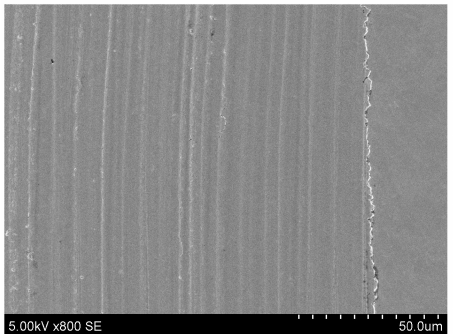
Figure 13. SEM images of a segment of wear trace on the plate formed during the tribo-test of W +